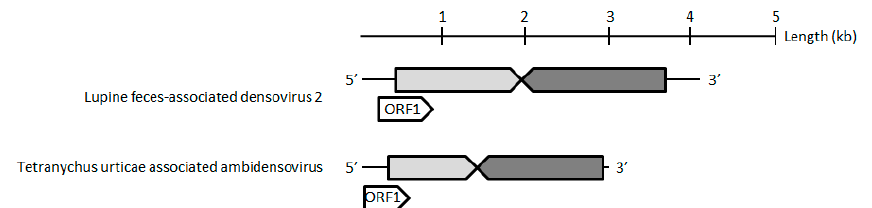
Figure 2. Maximum Parvoviridae likelihood phylogenetic tree based on a part of the NS1 protein containing the SF3 domain, including 105 parvovirus sequences and Tetranychus urticae-associated ambidensovirus (in bold). The alignment of 155 amino acids in length was produced using MUSCLE 3.7 (16 iterations) and was ungapped by hand. The tree was rooted with the SF3 domain of the Variola virus D5 protein. Bootstrap values are indicated at each node. Scale bar corresponds to amino acid substitutions per site. Genera of the Parvoviridae family are indicated in brackets. Genomic organization of Tetranychus urticae-associated ambidensovirus is also indicated. Grey arrows and rectangles: predicted open reading frames (ORF), Light grey: putative NS; dark grey: putative capsid protein (CP or VP). Arrow: complete ORF.